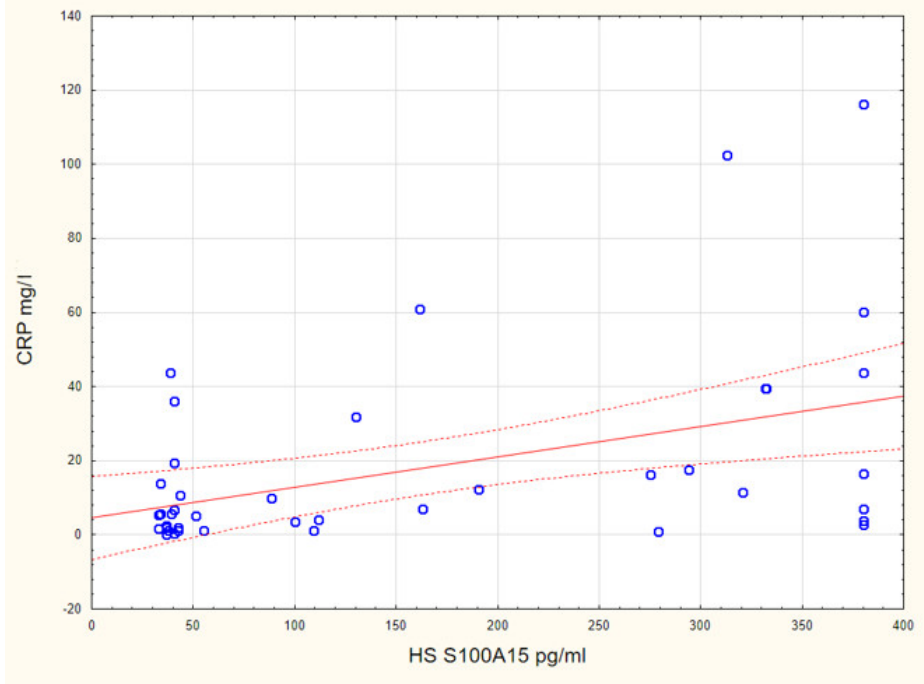
Figure 5. The serum concentration of S100A15 in individuals with HS was positively correlated with CRP concertation ( p = 0.004, R = 0.425)